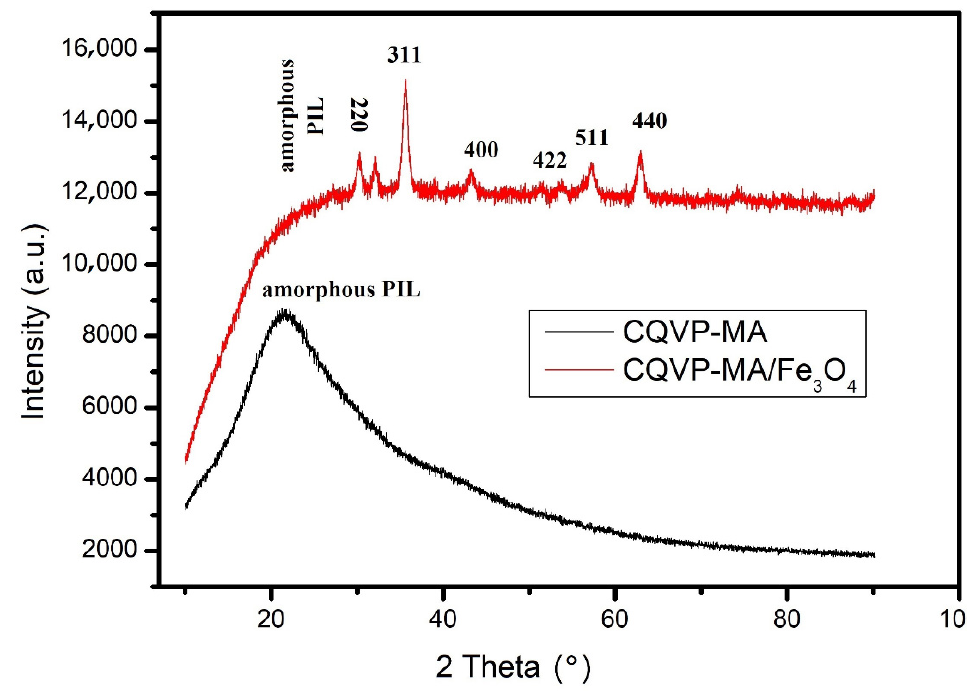
Figure 2. XRD diffractograms of CQVP/MA and CQVP/MA-Fe 3 O 4 .